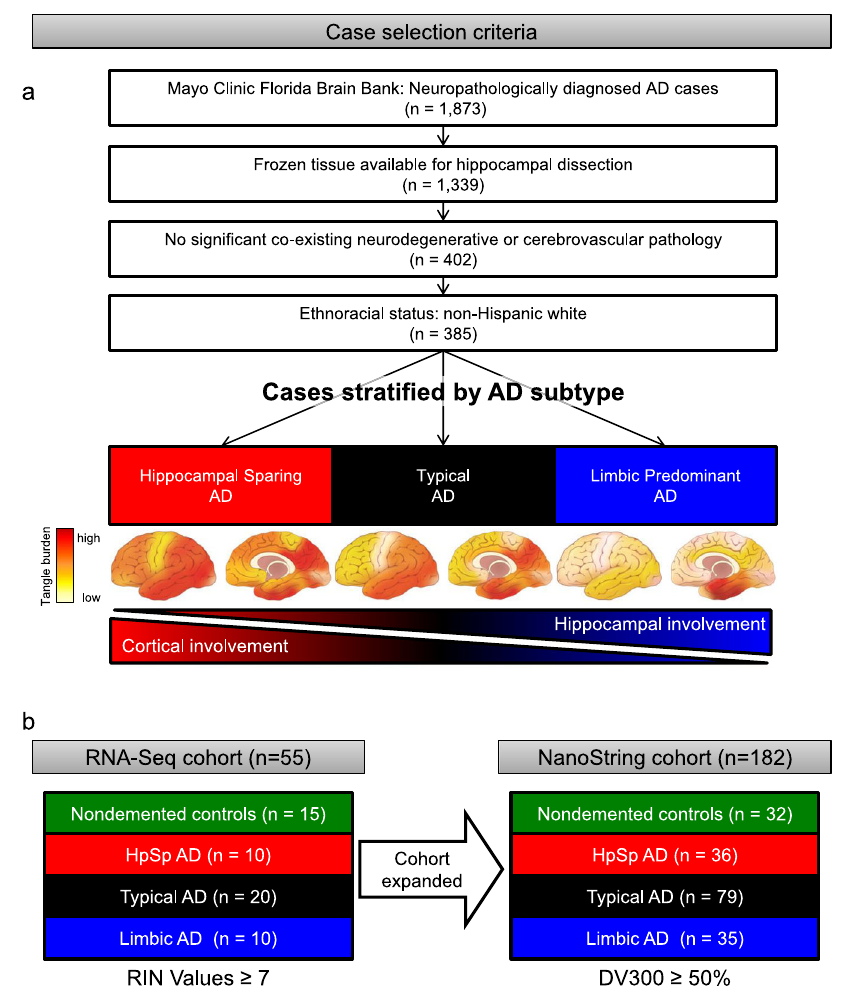
Fig. 1 Case selection criteria and neuropathologic subtyping of AD. a Flowchart describing selection criteria of AD cases to obtain frozen hippocampal tissue used to perform RNA-Seq and NanoString studies. AD cases were subtyped using a validated algorithm based on topographic distribution of hippocampal and cortical neuro fi brillary tangles 13 . Brain cartoons illustrate corticolimbic patterns of neuro fi brillary tangle burden throughout the brain in each AD subtype, where red indicates a high tangle burden and yellow/tan indicates a low tangle burden. b Overview of sample size for RNA-Seq and NanoString cohorts organized by AD subtype and control classi fi cation. Note: Cohort expansion for NanoString included all RNA-Seq cohort samples. AD, Alzheimer ’ s disease; DV300, distribution value over 300 base pairs; HpSp, hippocampal sparing; Limbic, limbic predominant; NFT, neuro fi brillary tangle; RIN, RNA integrity number; RNA-Seq, RNA